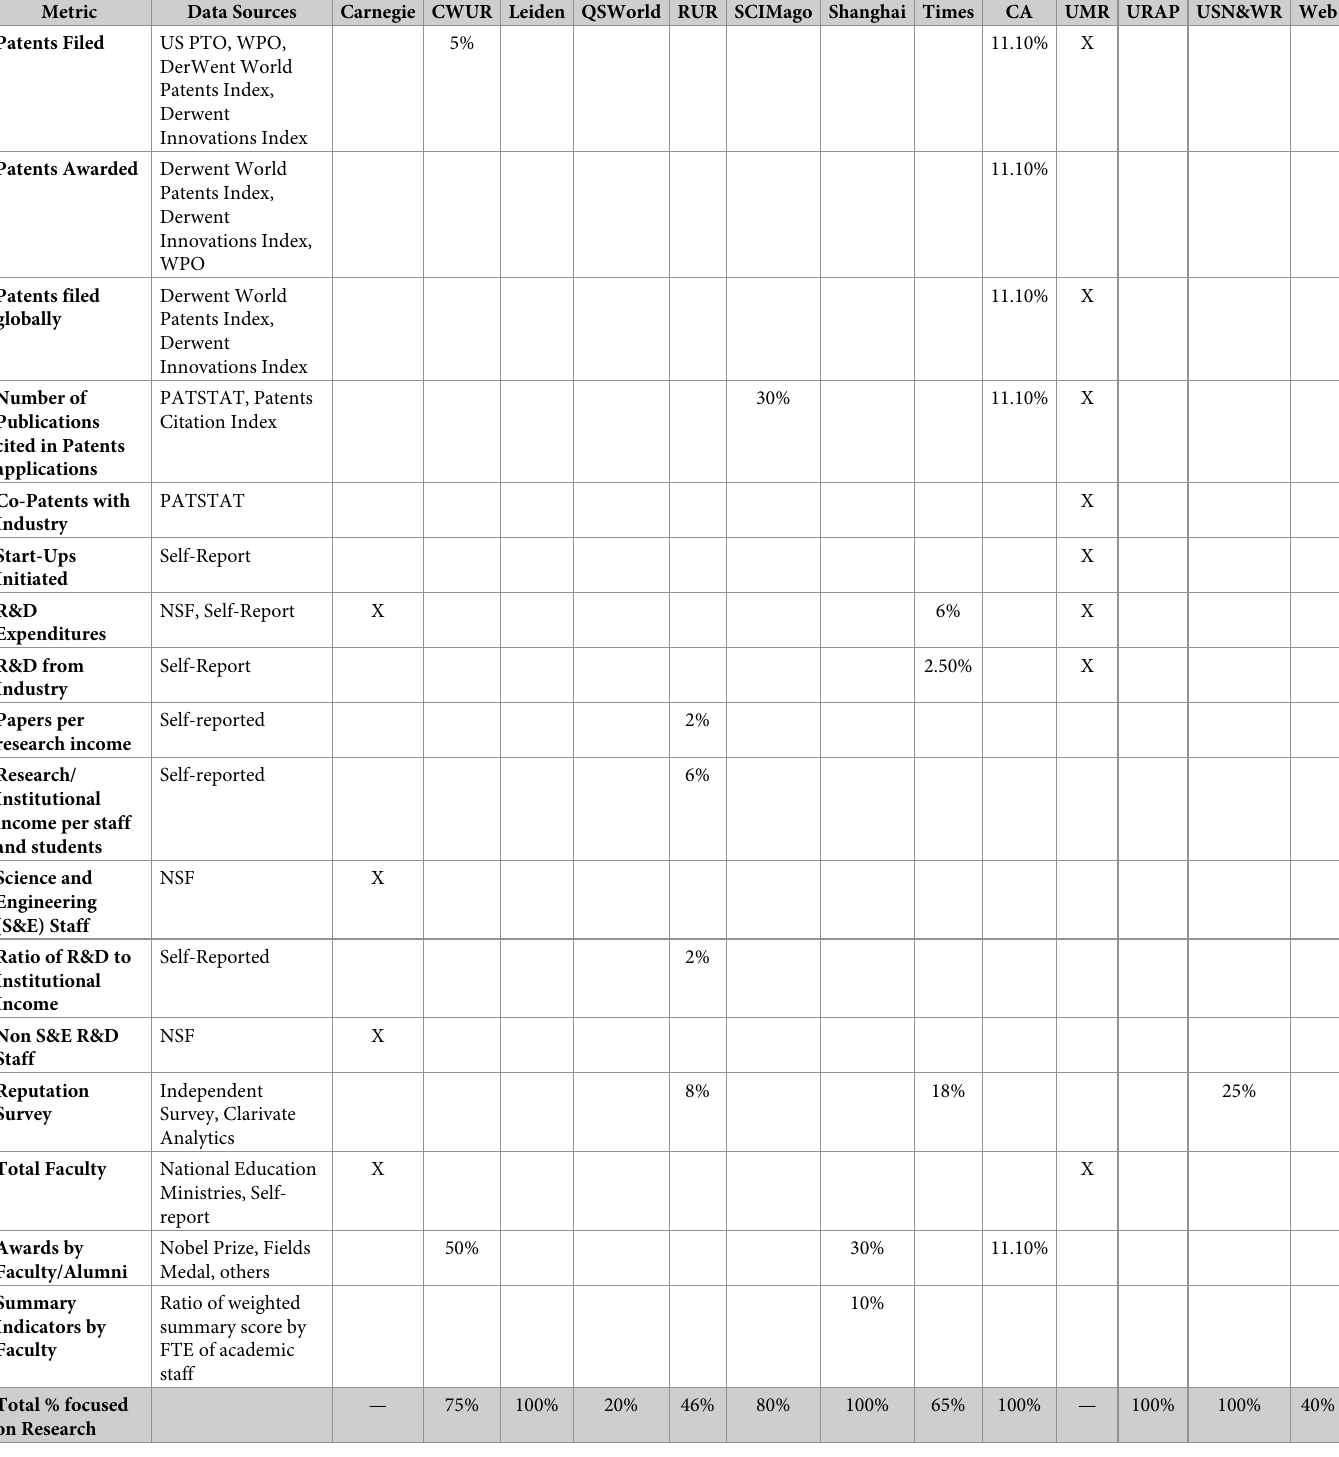
Table 4. Research indicators by intellectual property (percent of contribution to total score).